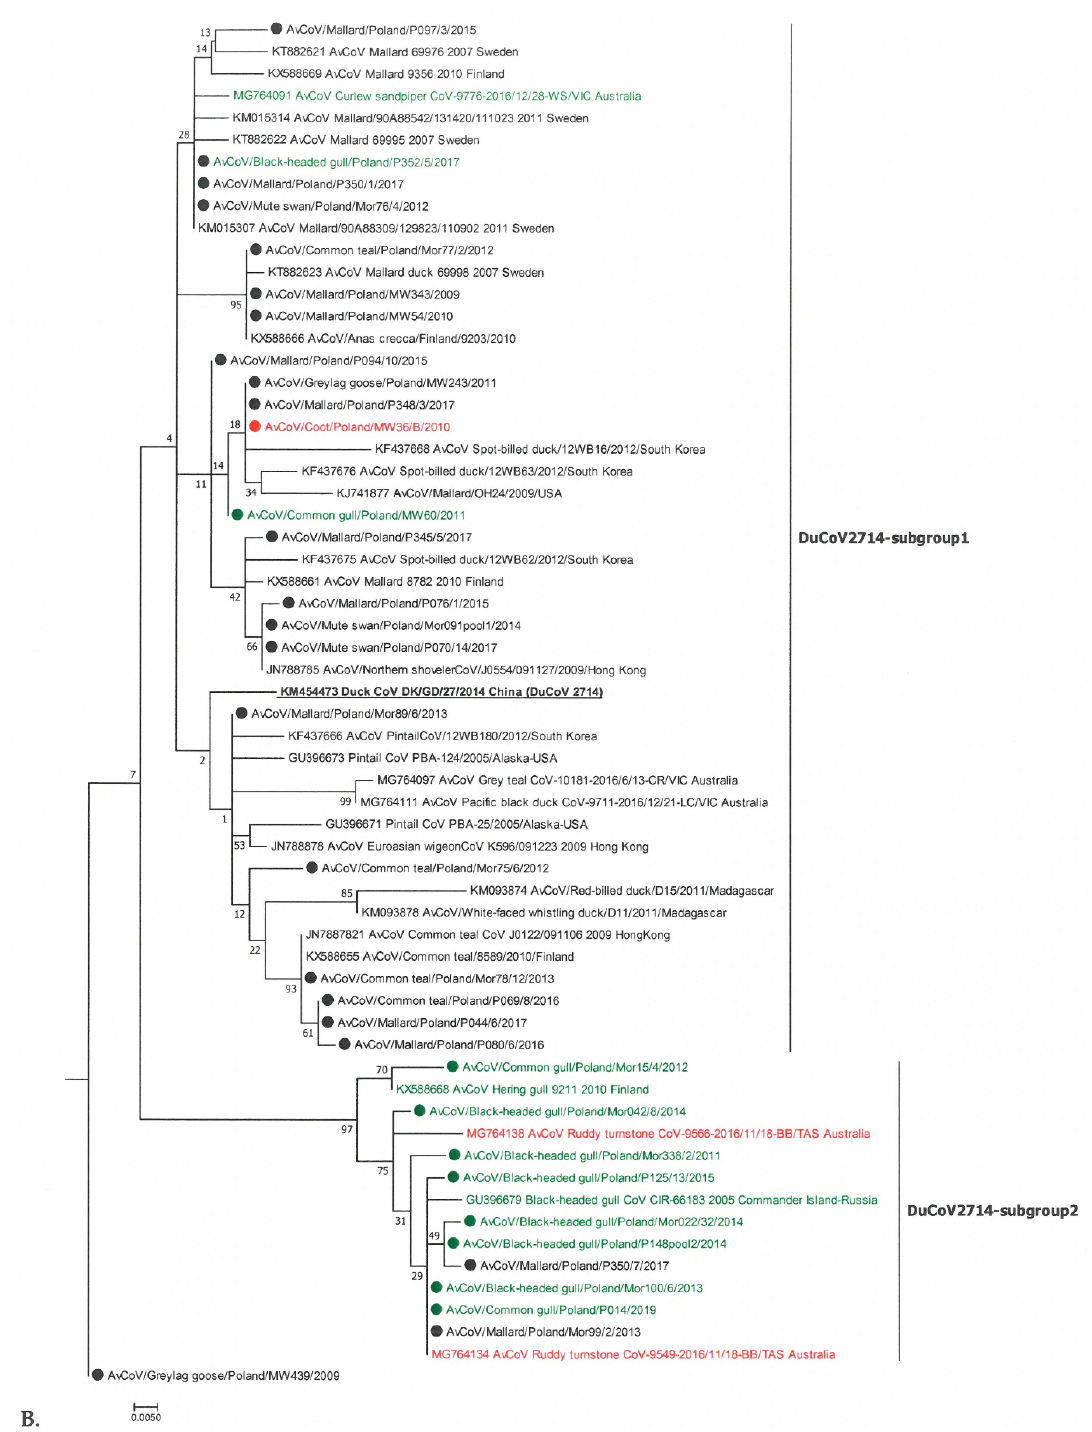
Figure 1. Phylogenetic analysis of gammacoronaviruses based on the replicase gene fragment. ( A ) The tree constructed for 108 gammacoronaviruses: 46 strains identified in wild birds in Poland (marked with a dot) and 62 from GenBank, including five reference strains (written in bold and underlined) representing ratified species of three subgenera ( Brangacovirus , Igacovirus , and Cegacovirus ) of the Gammacoronavirus genus. ( B ) Gammacoronaviruses of the Igacovirus subgenus, DuCoV2714 species. Colored font represents individual bird orders: black indicates Anseriformes , green indicates Charadriiformes , and red indicates other bird orders. The tree was constructed using MEGA 7 using the maximum likelihood method based on the T92 + G model and 1000 bootstrap replicates (bootstrap values shown on the tree).